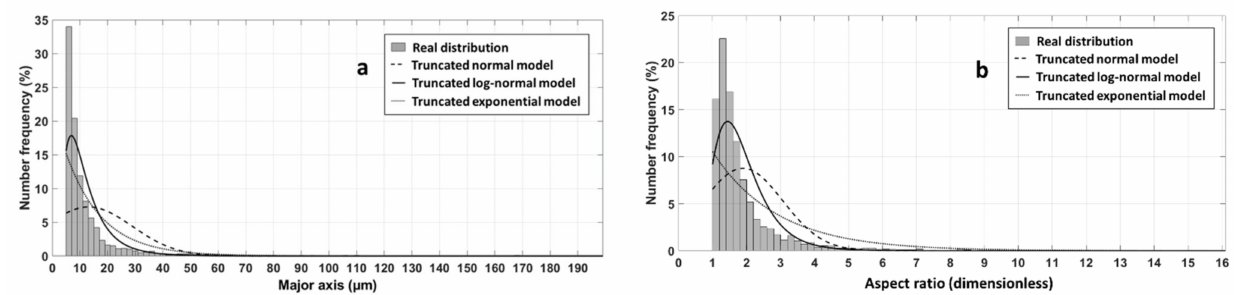
Figure 3. Comparison between experimental distribution and fitted distributions of ( a ) major axis and ( b ) aspect ratio obtained from 2869